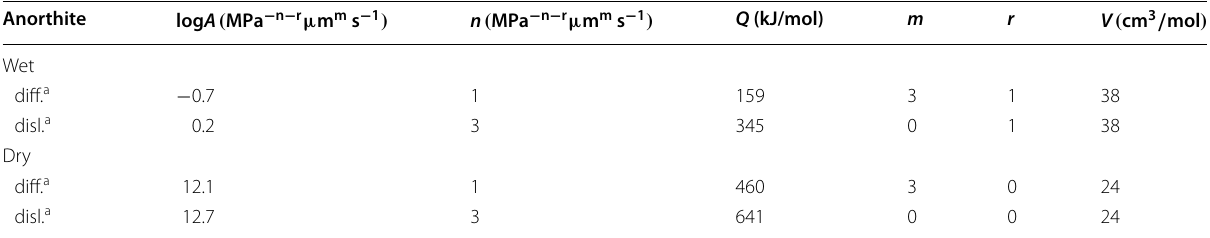
Table 2 Rheological properties of rocks from laboratory measurements (Rybacki et al. 2006)